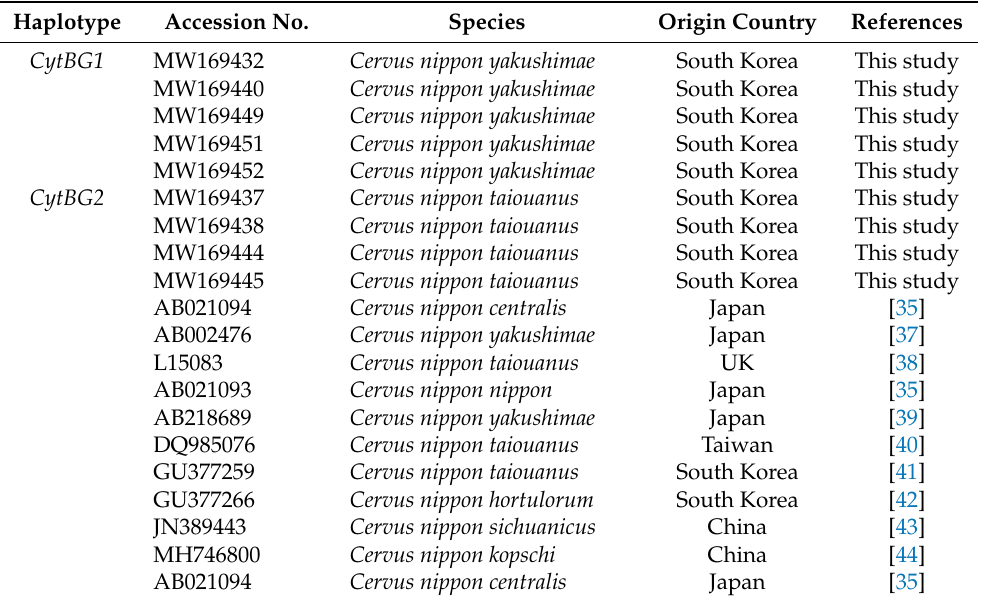
Table 1. Accession numbers of CytB gene sequence and corresponding haplotypes of C. nippon used in this